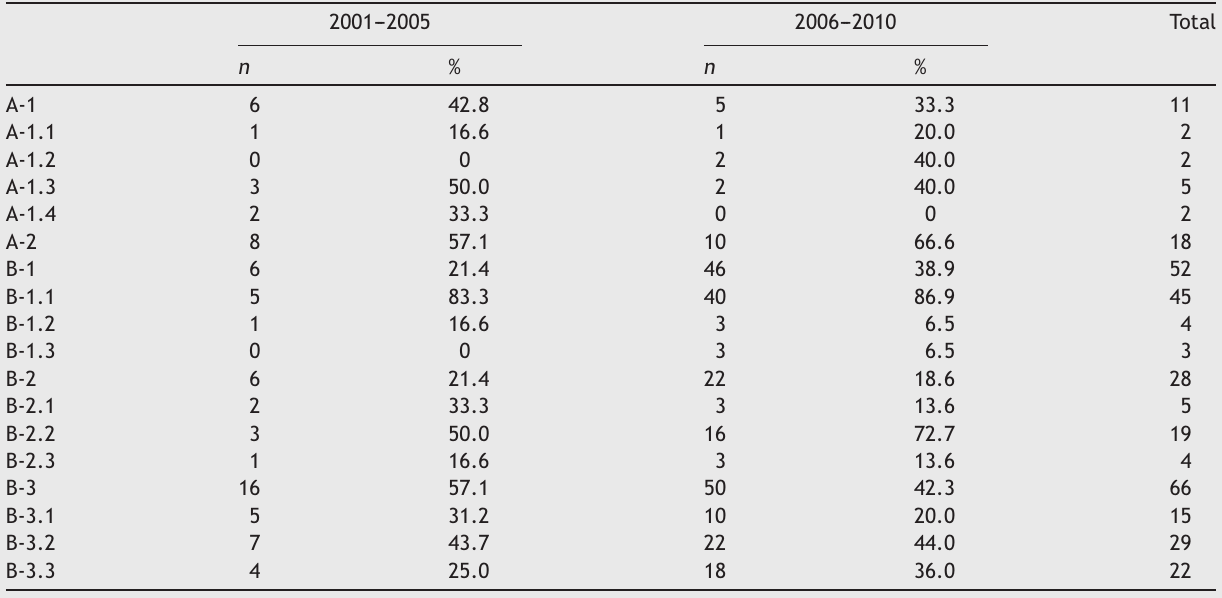
Table 3 Distribution of absolute and relative frequencies according to the categories generated on content analysis, with a comparison of the two halves of the